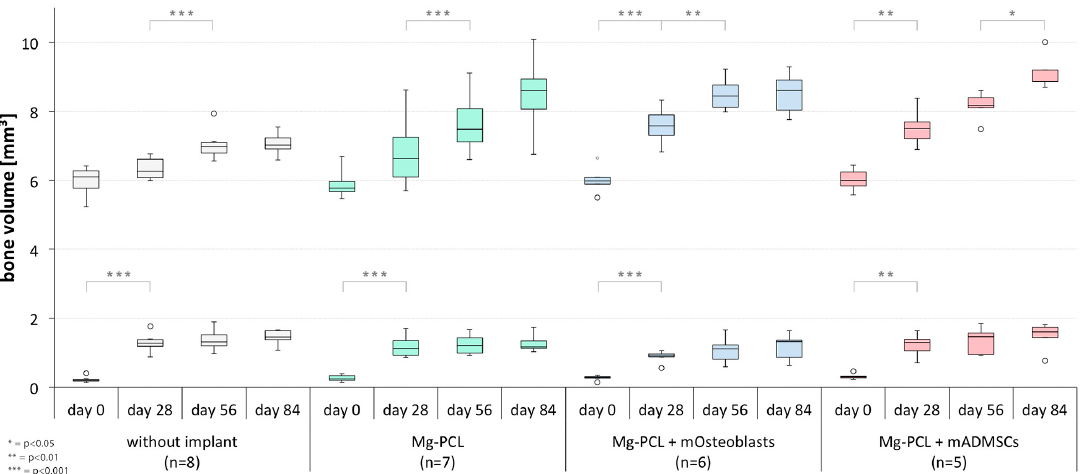
Figure 8. Comparative presentation of the formation of bone volume on the defect treated right side (lower row) and untreated left side (upper row) between the different measurement times within each experimental group (*= p < 0.05; ** = p < 0.01; *** = p < 0.001; whiskers = minimal and maximal values; horizontal line = median; circles = outliers).